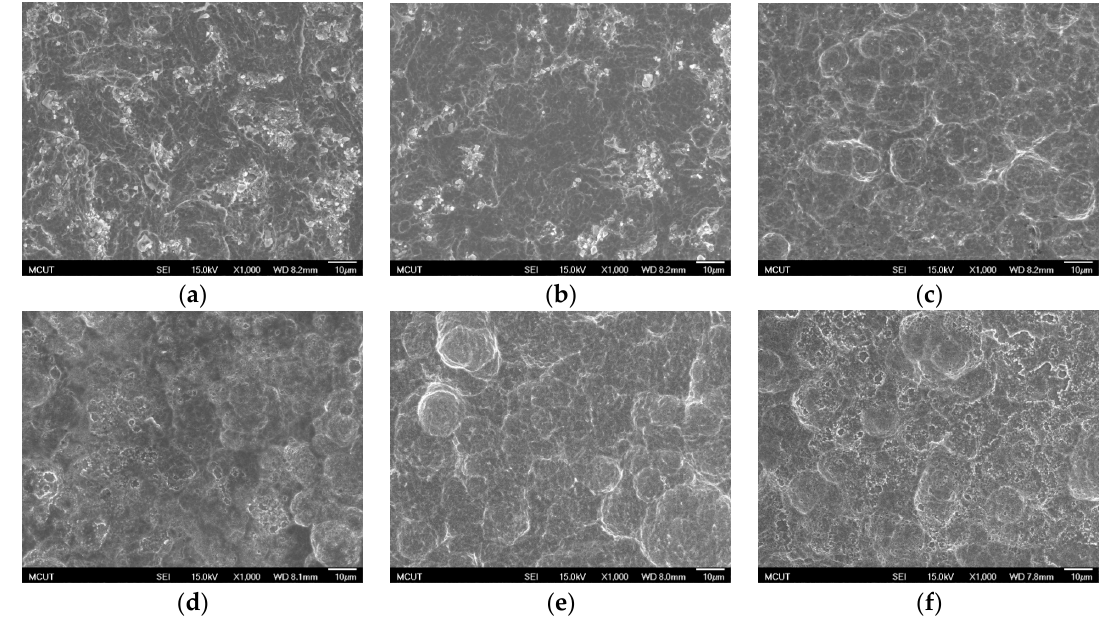
Figure 8. SEM images of Ti-6Al-4V surface after dual acid etching at RT and at BT (1000× magnification): ( a ) HF/H 2 SO 4 /HCl; ( b ) HF/HCl/H 2 SO 4 ; ( c ) HF/H 2 SO 4 (120 °C)/HCl (80 °C); ( d ) HF/HCl (80 °C)/H 2 SO 4 (120 °C); ( e ) H 2 SO 4 (120 °C)/HCl (80 °C); and ( f ) HCl (80 °C)/H 2 SO 4 (120 °C).